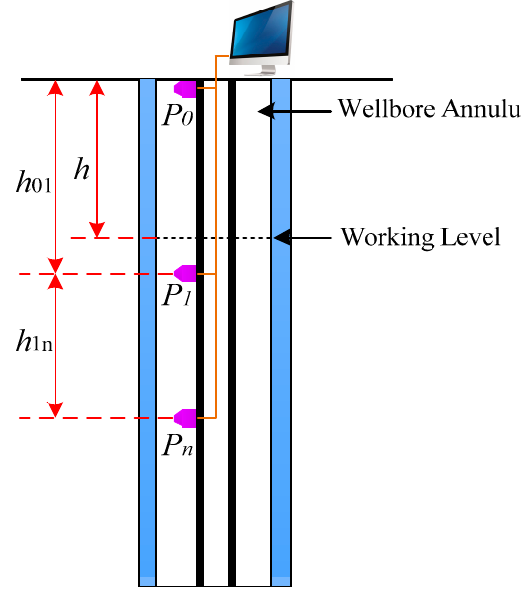
Figure 1. Principle of the pressure detection measurement.